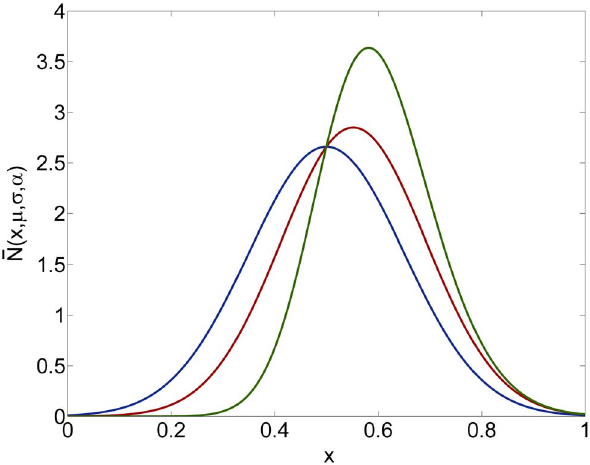
Figure 7. The skew normal distribution. Plots of (cid:2) NN ( x , m , s , a ) , where m ~ 0 : 5 , s ~ 0 : 15 and skewness a ~ 0 , 0 : 5 , 1 : 5 corresponds to the blue, red and green line respectively.